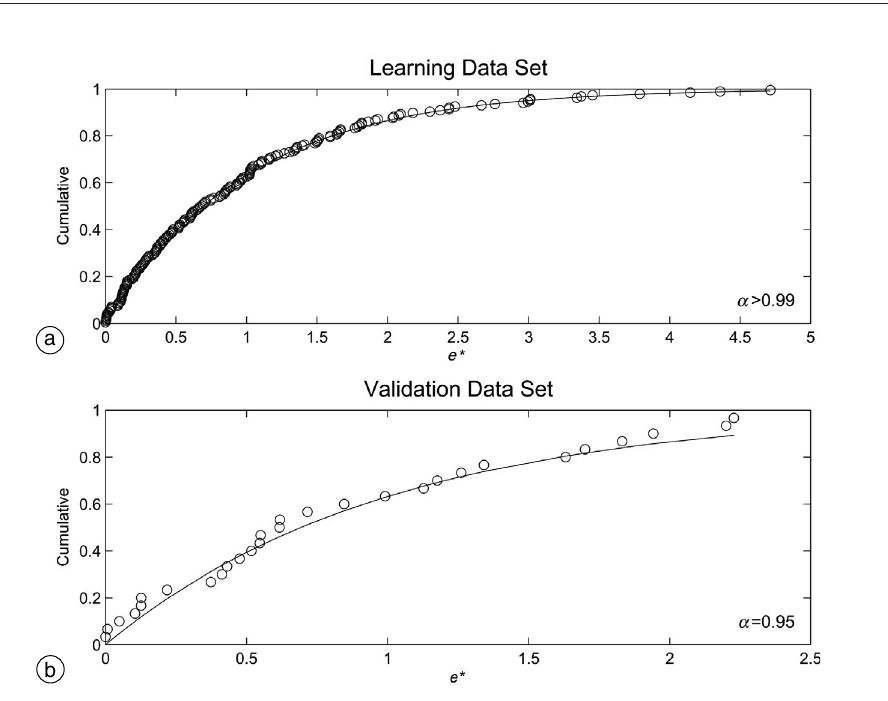
Fig. 3a,b. a) Empirical and theoretical (solid line) cumulative functions for the learning dataset. The parame- ter α is the significance level at which the null hypothesis (Poisson hypothesis) can be rejected (see text for more details). b) The same as (a), but relative to the validation